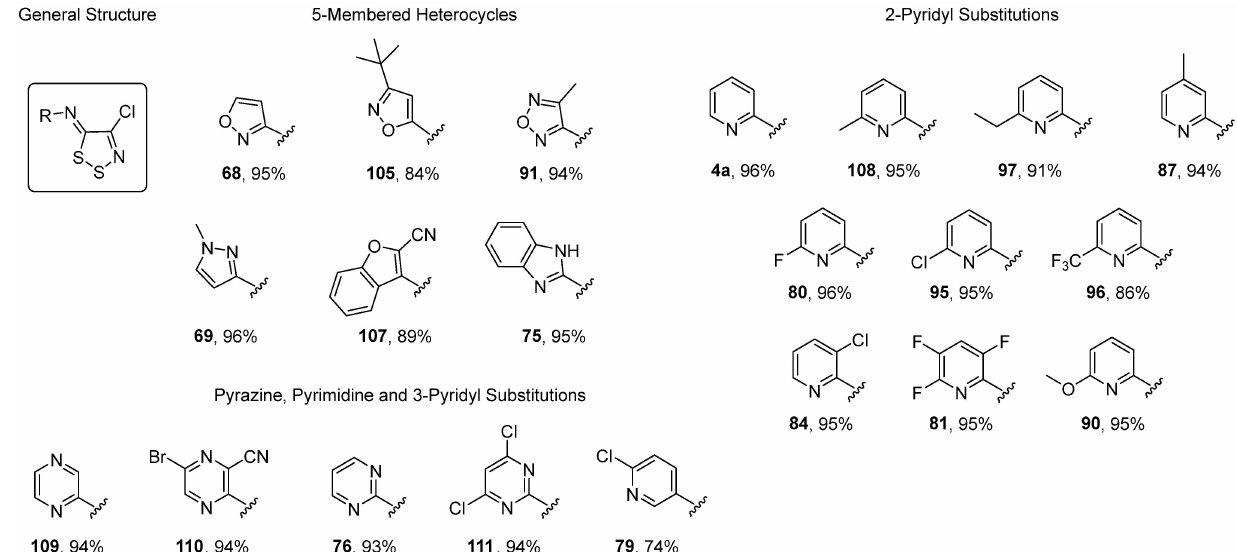
Figure 15. Alternia (tomatoes) preventive ≥ 70% efficacy at concentration of 250